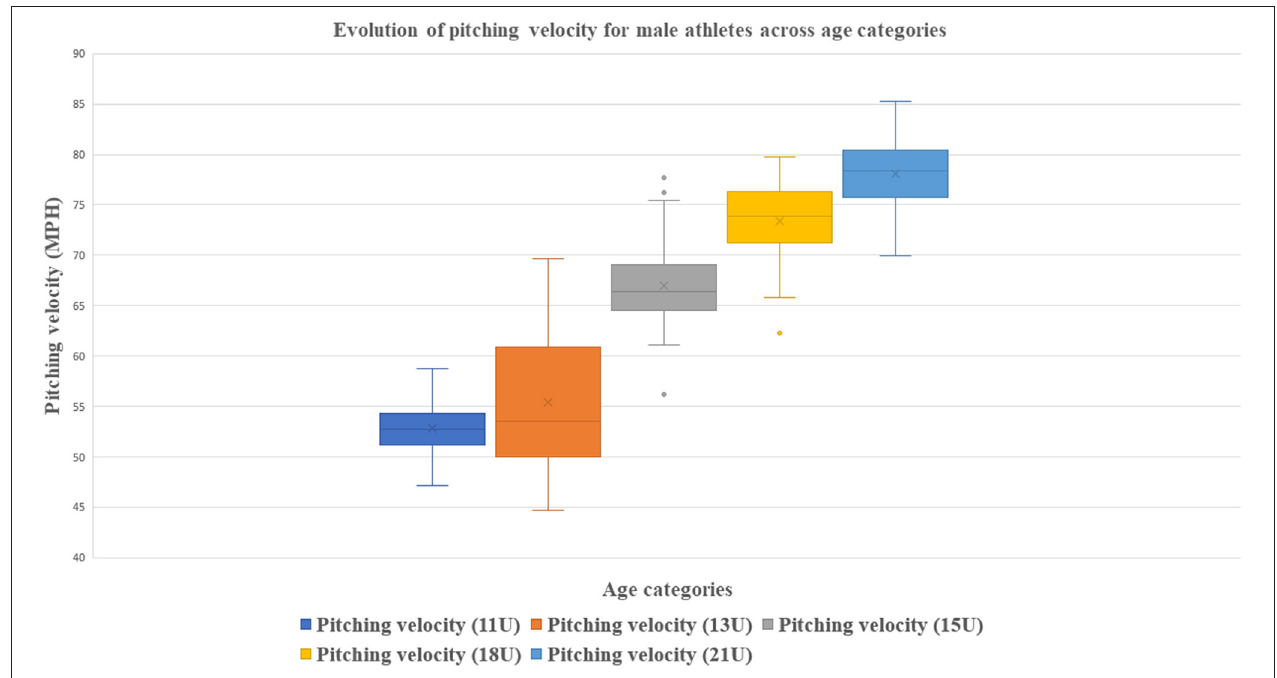
FIGURE 1 | Evolution of pitching velocity across age categories for male athletes.